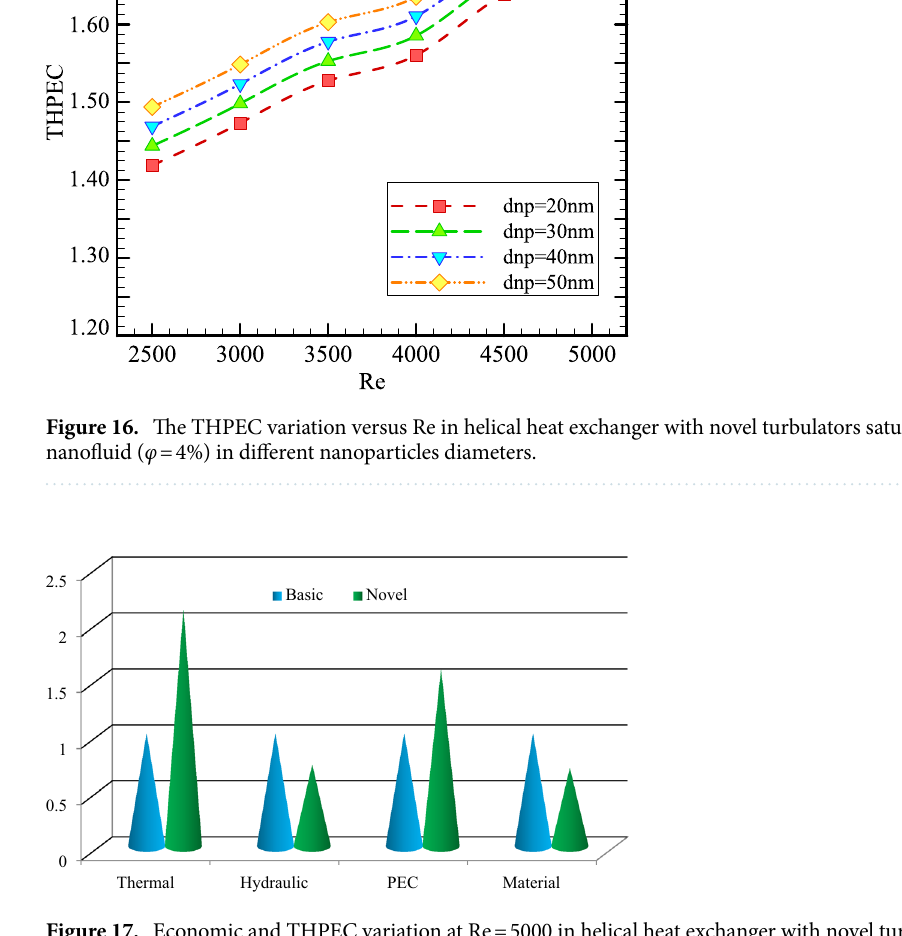
Figure 17. Economic and THPEC variation at Re = 5000 in helical heat exchanger with novel turbulators saturated with nanofluid ( φ = 4% and d np = 50 nm) in comparison with basic